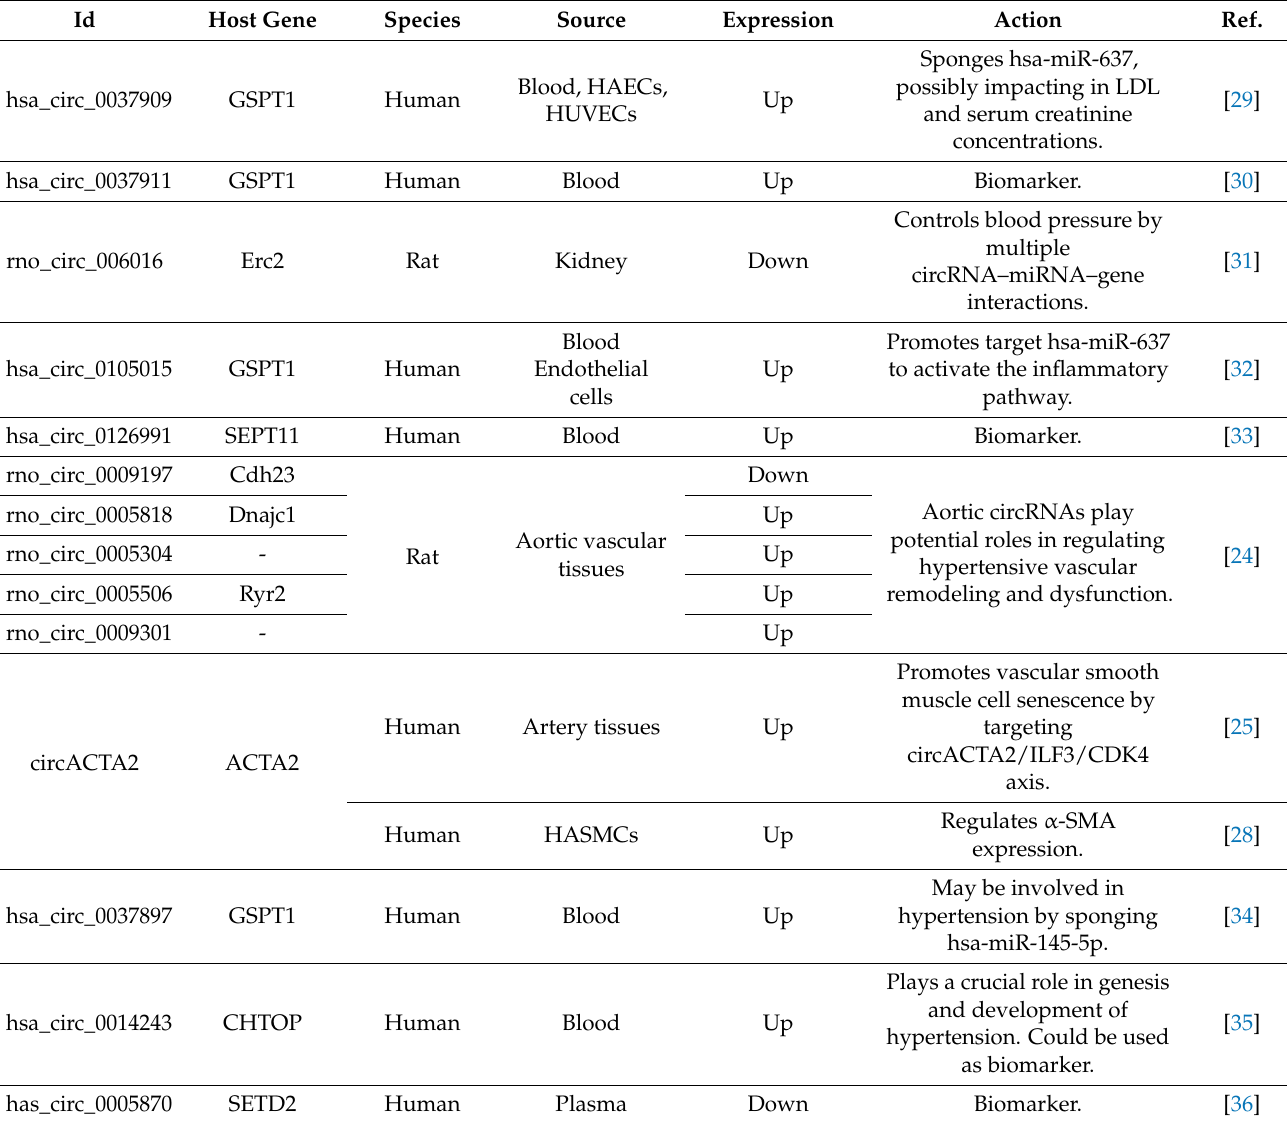
Table 1. List of circRNAs associated with arterial